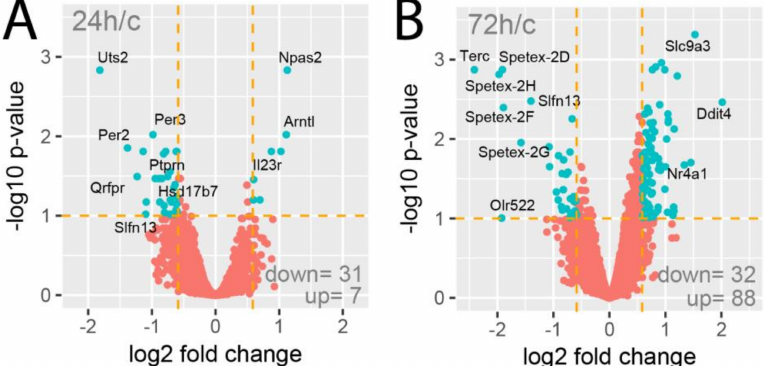
Figure 2. Volcano plots of total gene expression profiles of the right rat adrenals obtained 24 ( A ) or 72 h ( B ) after a left adrenalectomy in relation to adrenals from control rats. Each dot represents the mean expression ( n = 5) of individual genes obtained from a microarray normalized dataset. The orange dotted lines (cut-off values) were established according to the following parameters: fold = |1.5| and p -value with FDR correction =10%. Genes above the cut-off lines have been considered as differentially expressed genes (DEG) and are shown as turquoise dots. The total numbers of DEG are presented in the bottom right corner of the graph. Ten of the most regulated genes are marked by their gene symbols.